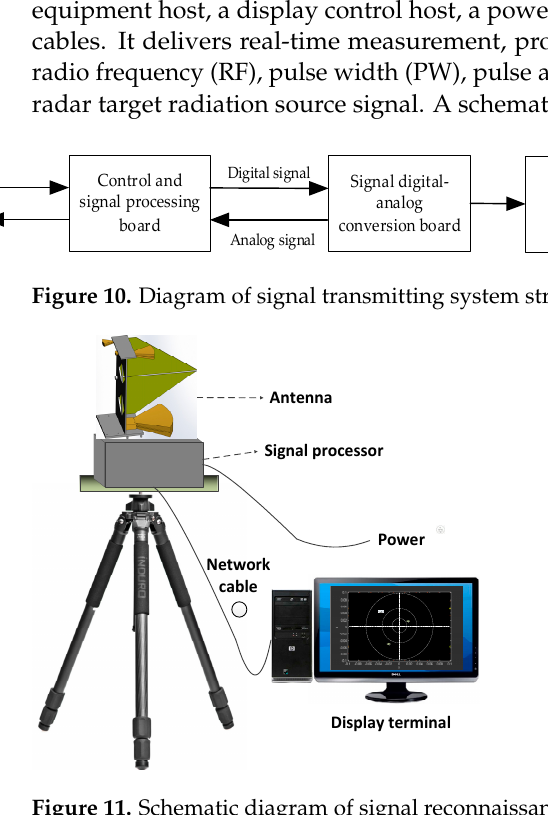
Figure 13. Display terminal interface of signal reconnaissance system.